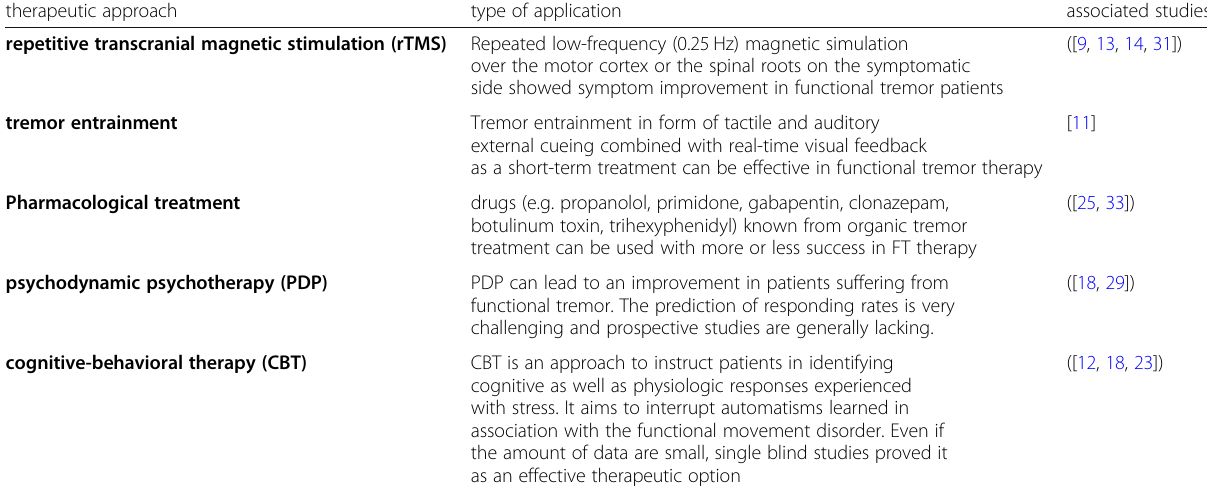
Table 4 Therapeutic methods evaluated to treat functional tremor therapeutic approach